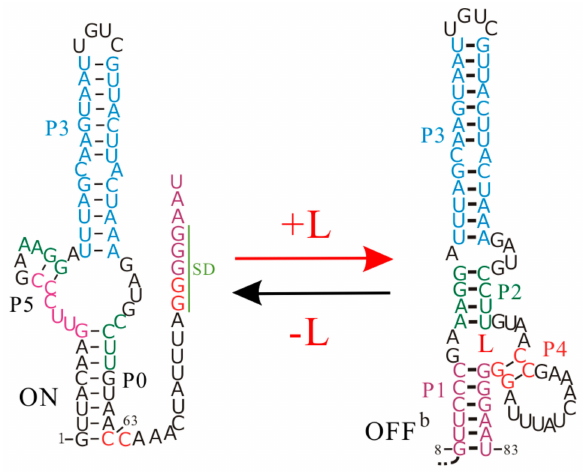
Figure 5. The regulation mechanisms of the S MK riboswitch. L is the ligand